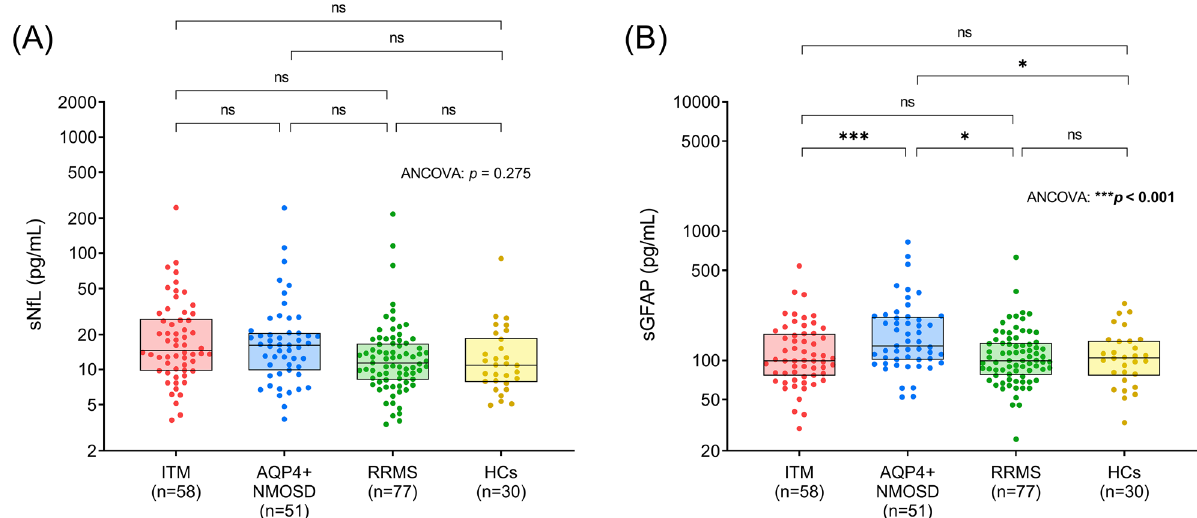
Figure 5. Comparisons of serum biomarkers between patients with ITM, AQP4 + NMOSD and RRMS in remission and HCs. All patients did not experience an acute transverse myelitis attack within the last two months before blood sampling. ( A ) sNfL and ( B ) sGFAP levels were compared between patients with ITM (n = 58), those with AQP4 + NMOSD (n = 51), those with RRMS (n = 77) and HCs (n = 30). The boxes represent medians and interquartile ranges (IQR). Age was regarded as a covariate in the analyses. p values with statistical significance (* p < 0.05, ** p < 0.01 and *** p < 0.001) are presented in bold. sNfL: serum neurofilament; sGFAP: serum glial fibrillary acidic protein; ITM: idiopathic transverse myelitis; AQP4 + NMOSD: aquaporin-4 antibody-positive neuromyelitis optica spectrum disorder; RRMS: relapsing–remitting multiple sclerosis; LETM: longitudinally extended transverse myelitis; ANCOVA: analysis of